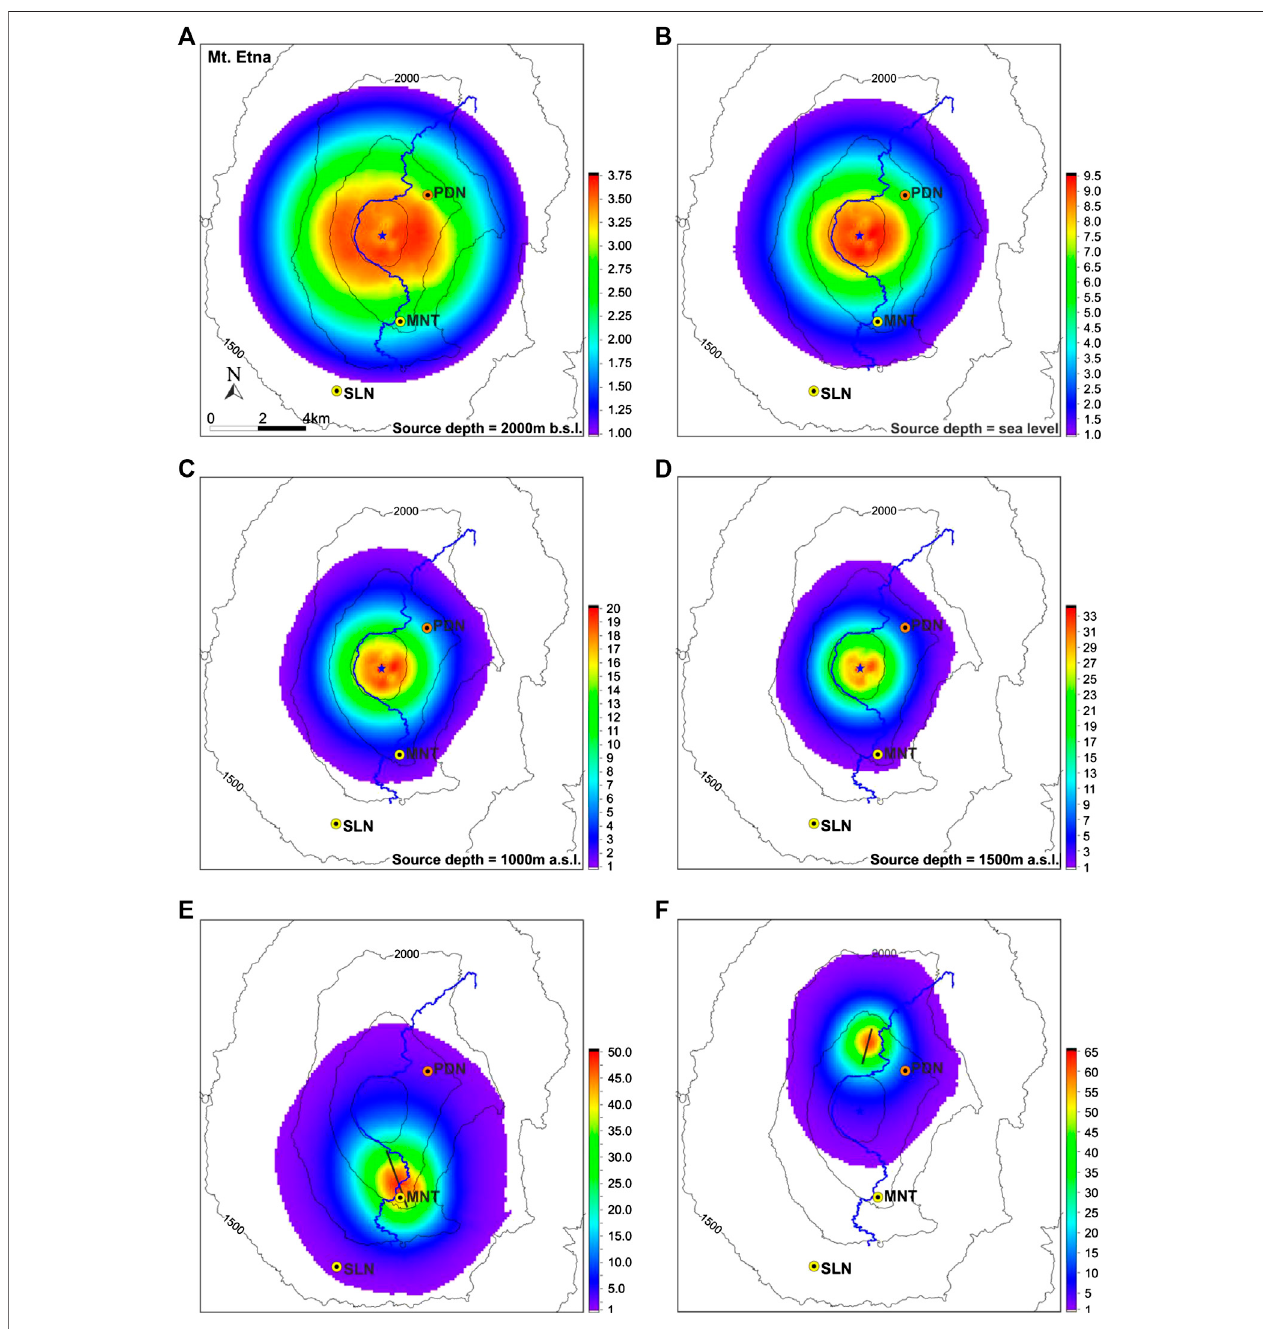
FIGURE12 | Maps ofMt. Etnashowing gravity anomalies (in µGal) inducedby different mass sources. (A – D) Gravity anomalies produced bya point source (mass change (cid:1) 1.45 × 10 10 kg, in all cases) beneath the summit craters at different depths: (A) 2 km b.s.l., (B) at sea level, (C) 1 km a.s.l., (D) 1.5 km a.s.l., and (E,F) Gravity effect(inµGal)duetoelongated masssources (dikes)belowthesouthand north-eastslopesofEtna. (E) Masschangeof2.5 × 10 10 kg,source depthat1,000 mabove sea level (Budetta et al., 1999). (F) Mass change of 1.5 × 10 10 kg, source depth at 1,500 m above sea level (Carbone et al., 2003). The maps also report positions of: the two higher gravity stations equipped with iGrav meters (SLN and MNT); the Pizzi Deneri Volcanological Observatory; the Summit road (blue track).